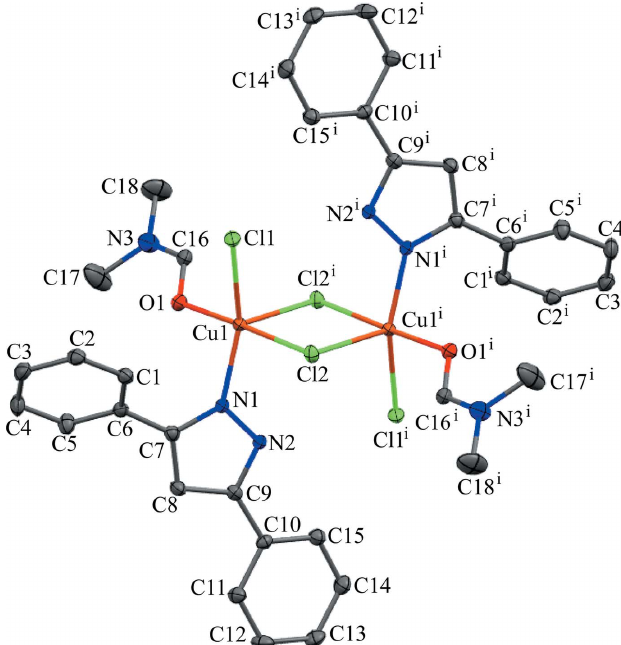
Figure 1 The molecular structure of ( 1 ) with displacement ellipsoids at the 50% probability level [symmetry code: (i) (cid:4) x + 1, (cid:4) y + 1, (cid:4) z ). For clarity, H atoms have been omitted. Color scheme: orange – Cu II , green – Cl, red – oxygen, blue – nitrogen, and gray – carbon. All figures were generated with the program Mercury (Macrae et al. , 2006).